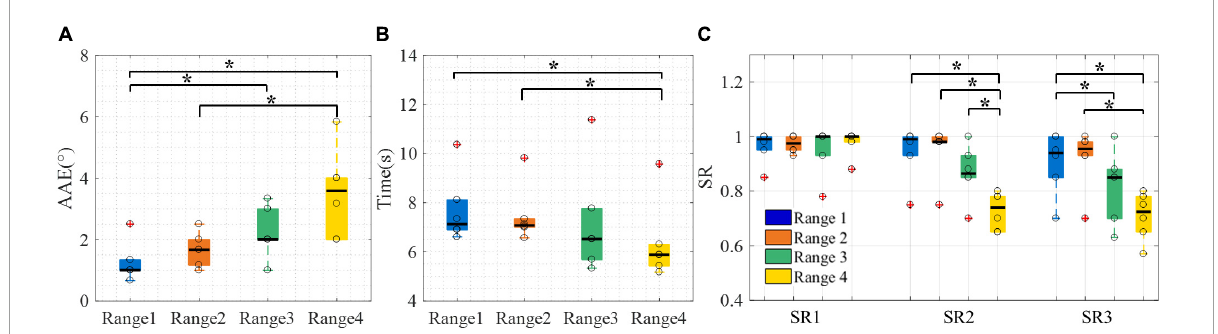
FIGURE6 The control performance of the arm prosthesis with different perception ranges. (A) AAE, (B) CT, (C) SR. Boxplots depict the median ( line ), interquartile range ( box ), maximal/minimal values ( whiskers ), and outliers ( crosses ). The hollow circle denotes the median AAE, CT, and SR of each subject in panels (A–C) , respectively. A star denotes the statistically significant differences (* p < 0.05). AAE, absolute angular error; CT, completion time; SR1 to SR3, success rate when considering time threshold, angle threshold, and combination of the time and angle thresholds,